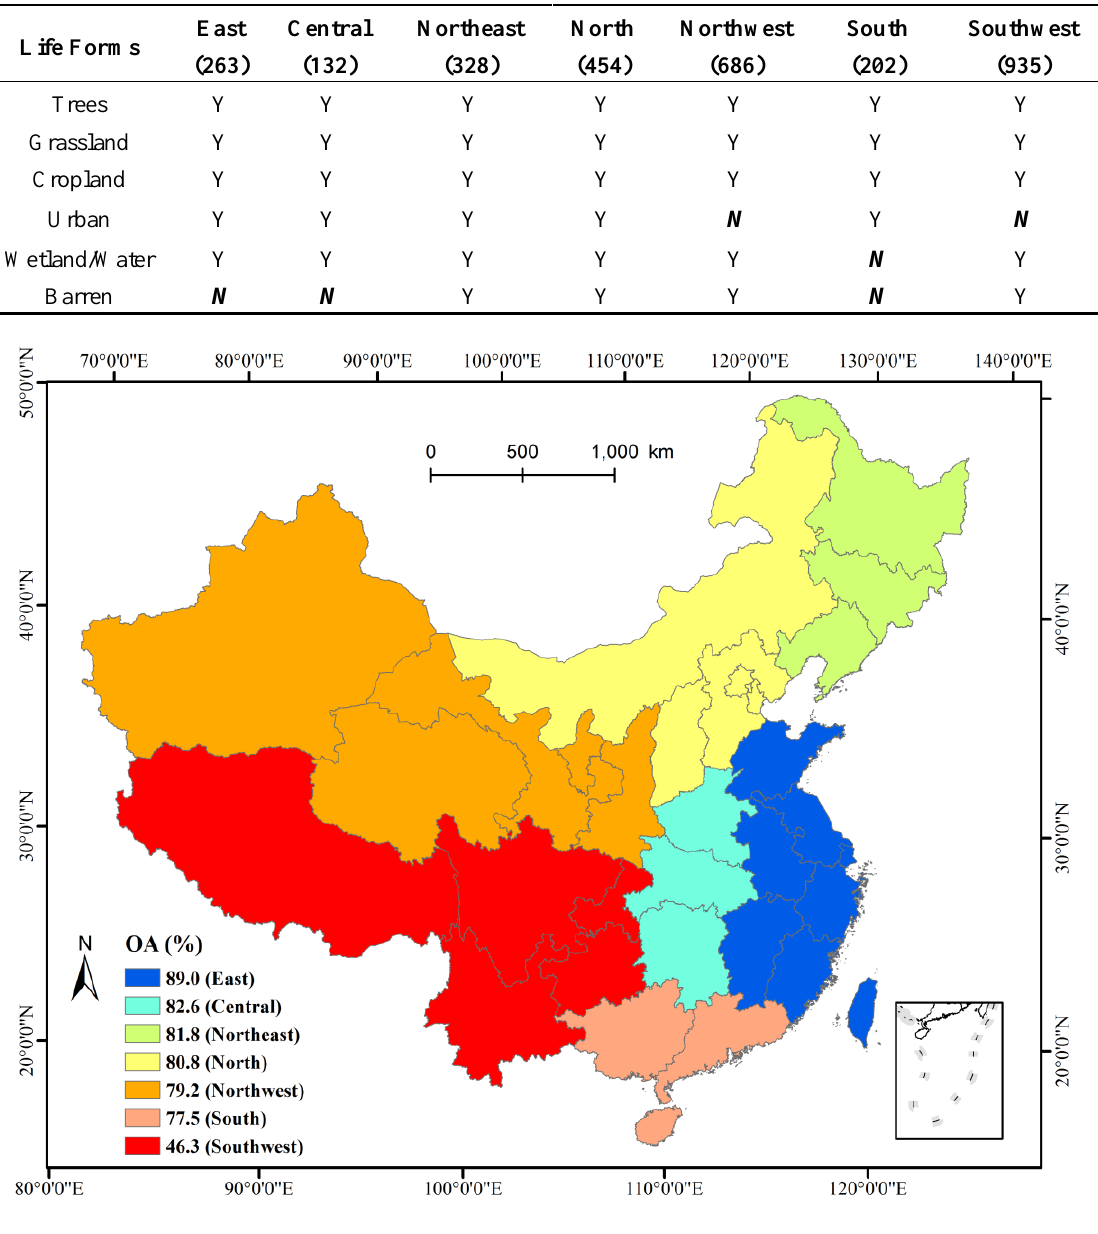
Figure 7. Overall accuracy for GLCD-2005 over seven geographical regions of